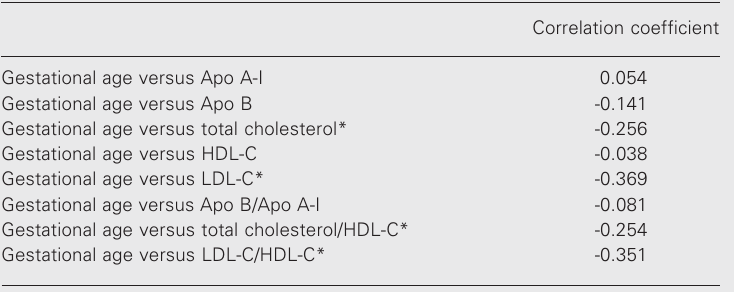
Table 4. Correlation coefficients between lipid profile and gestational age of 135